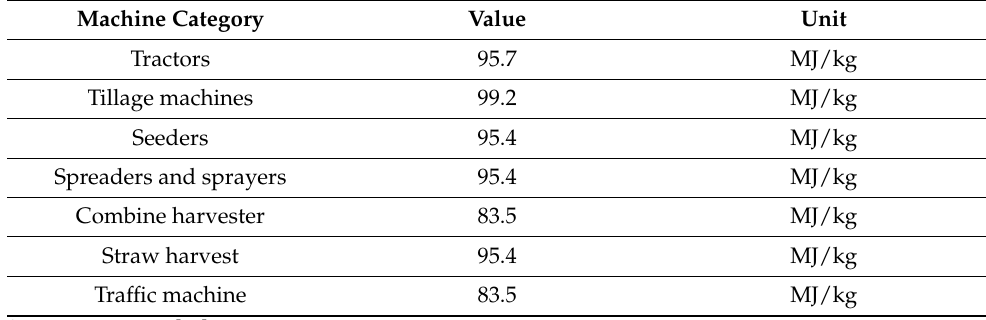
Table A5. Conversion factors for calculating the energy contained in machines.